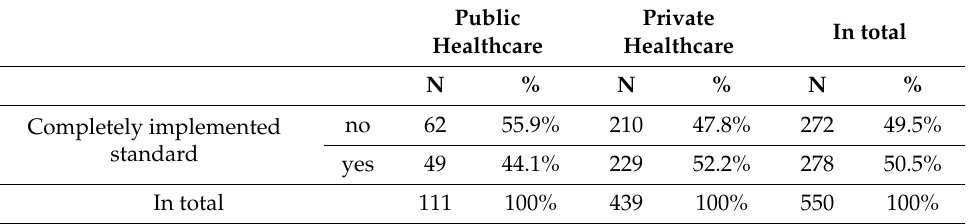
Table 5. Characteristics of prenatal care standard implementation in public and private healthcare